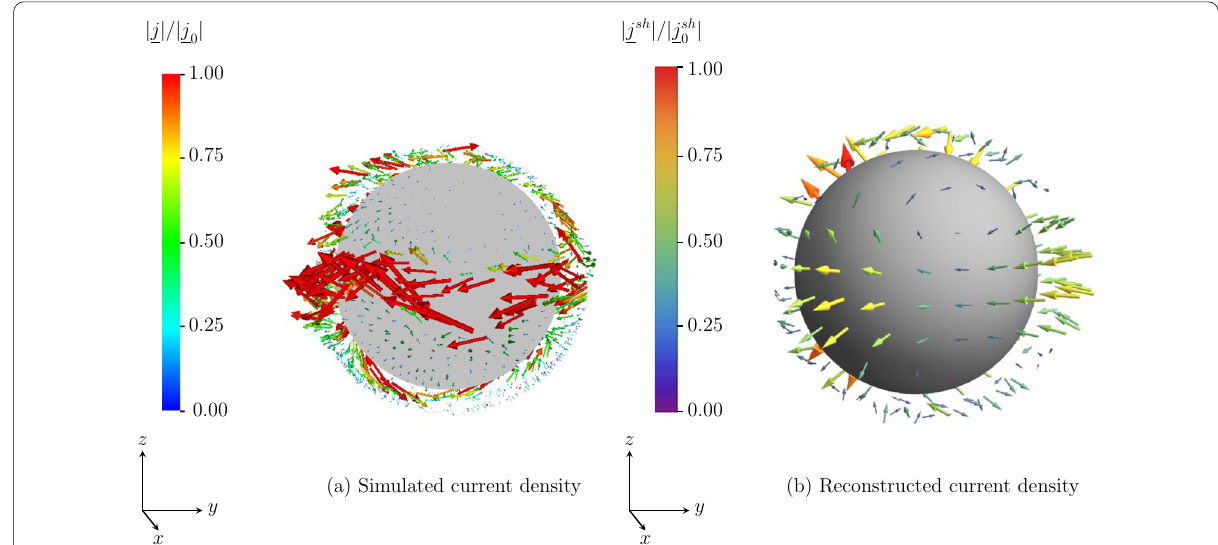
= 25nA / m 2 along the j sh 0 (cid:31) (cid:31) (cid:31) (cid:31)